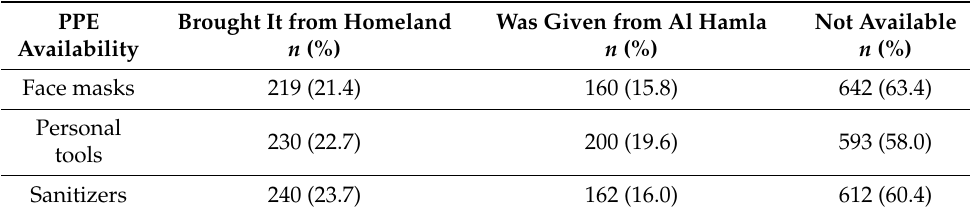
Table 6. Responses to items on aspects of availability and the sources of Personal Protective Equip- ment (PPE) ( n =